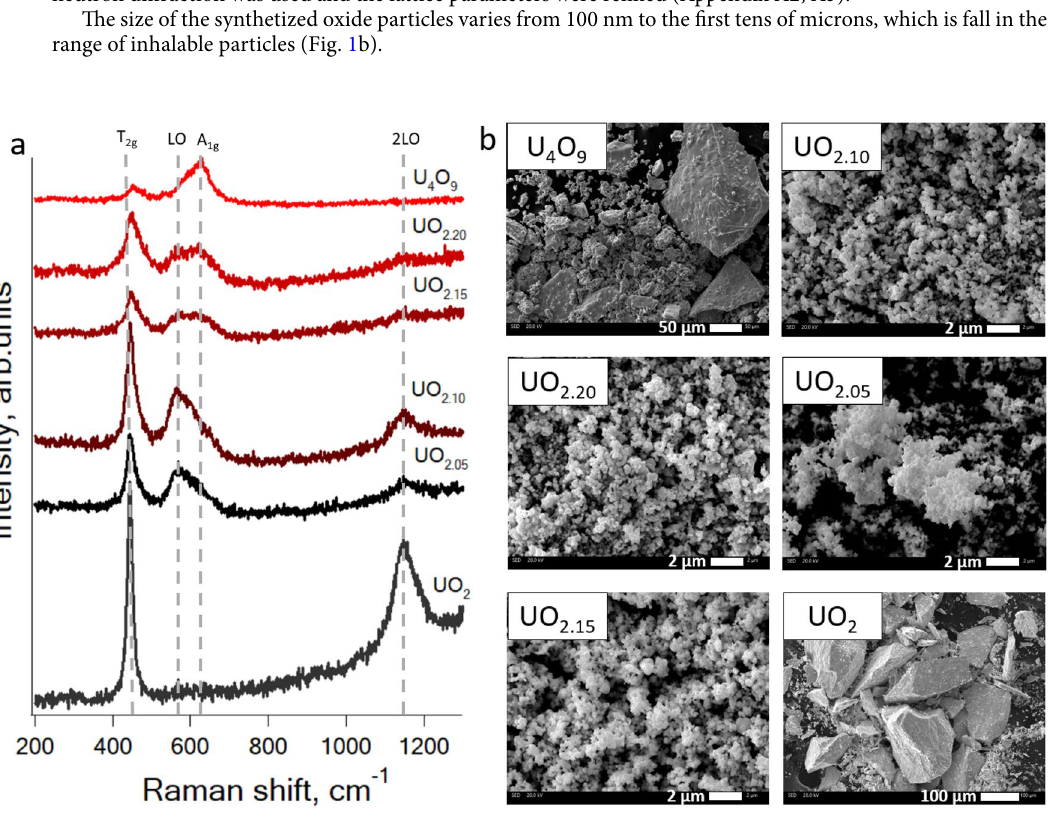
Figure 1. ( a ) Raman spectra of uranium oxides from UO 2 to U 4 O 9 . ( b ) SEM images of uranium oxides from